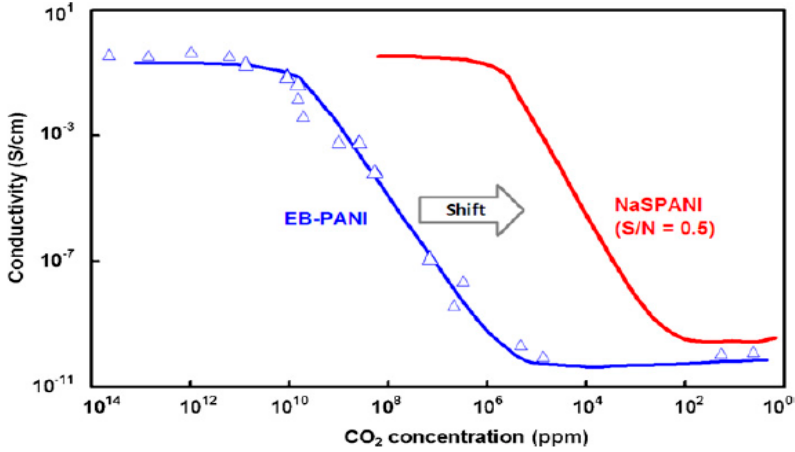
Figure 7. Conductivity of sensor with concentration of carbon dioxide. Reproduced with permission from reference [19]. EB-PANI: emaraldine base polyaniline. NaSPANI: sodium sulfonated PANI.